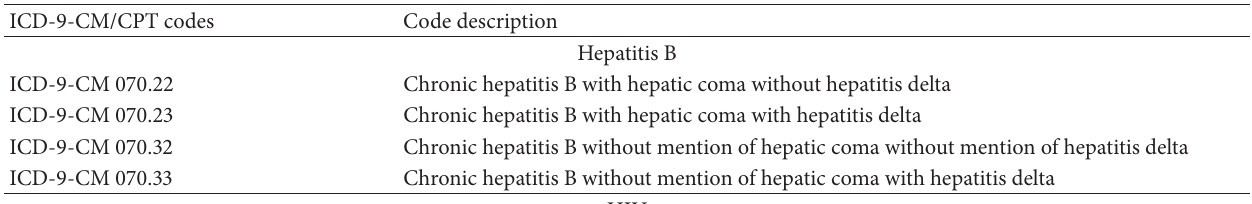
Table 1: List of international classification of diseases, 9th revision, clinical modification (ICD-9-CM), and current procedural terminology (CPT) codes for chronic hepatitis B, pregnancy, delivery, and